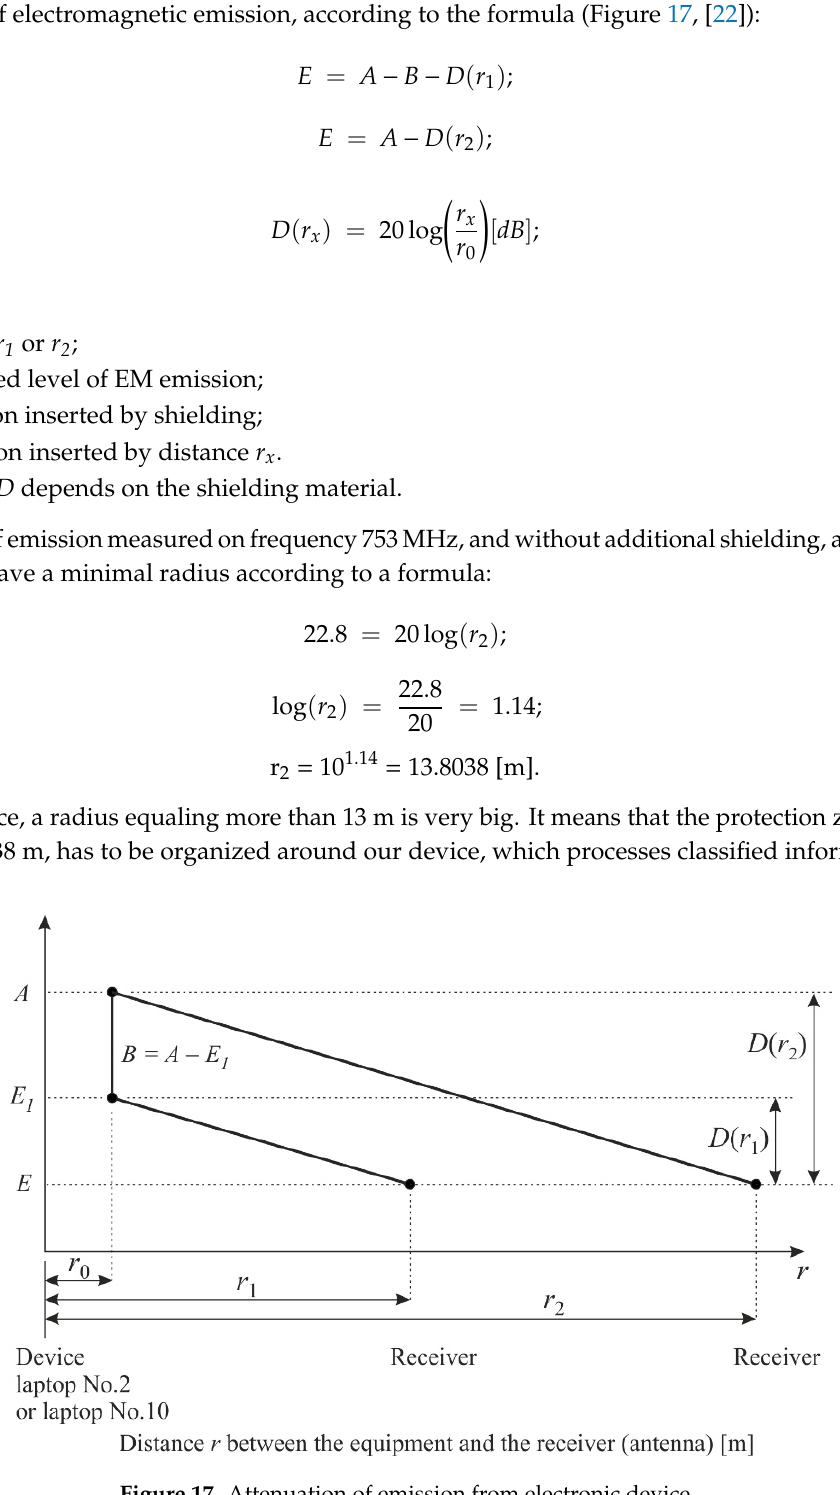
Figure 17. Attenuation of emission from electronic device